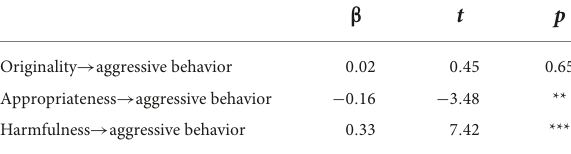
TABLE 2 Social creativity’s direct effects on aggressive behavior.